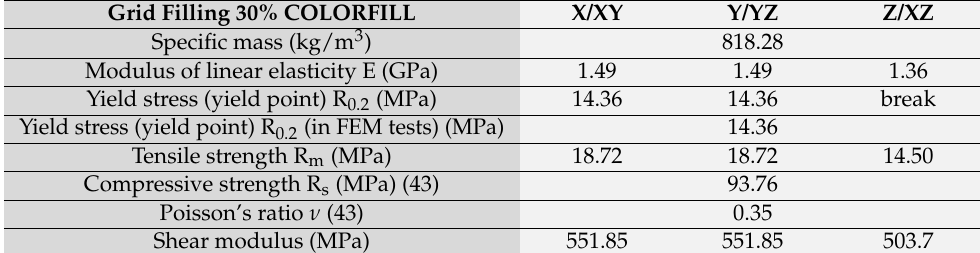
Table 11. Mechanical properties of PLA Colorfill with 30% grid filling